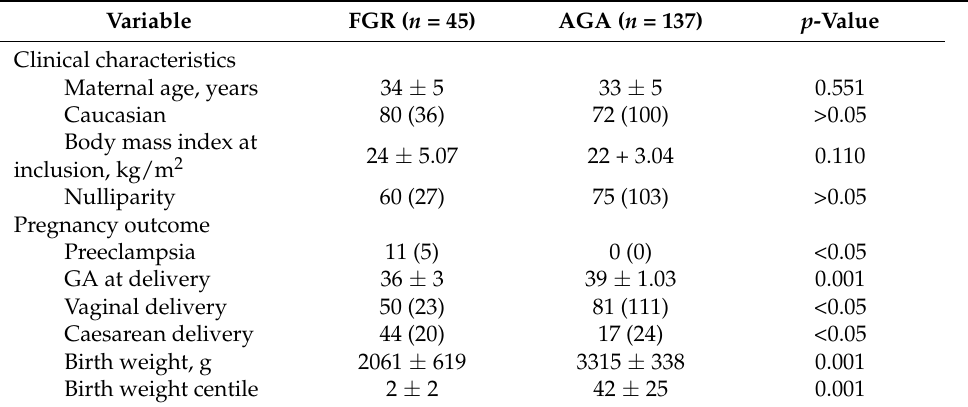
Table 1. Basic characteristics of the study population.